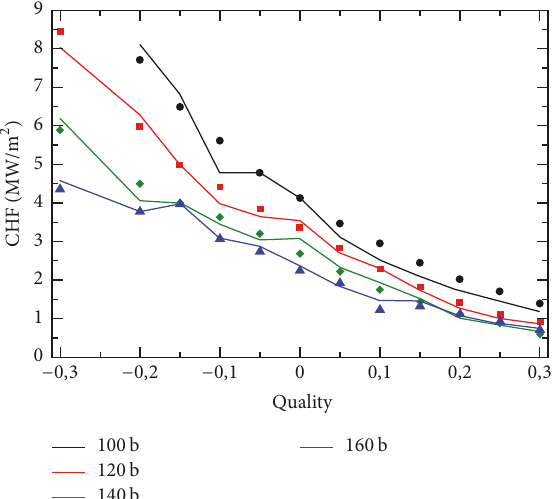
Figure 50: 1500 validation